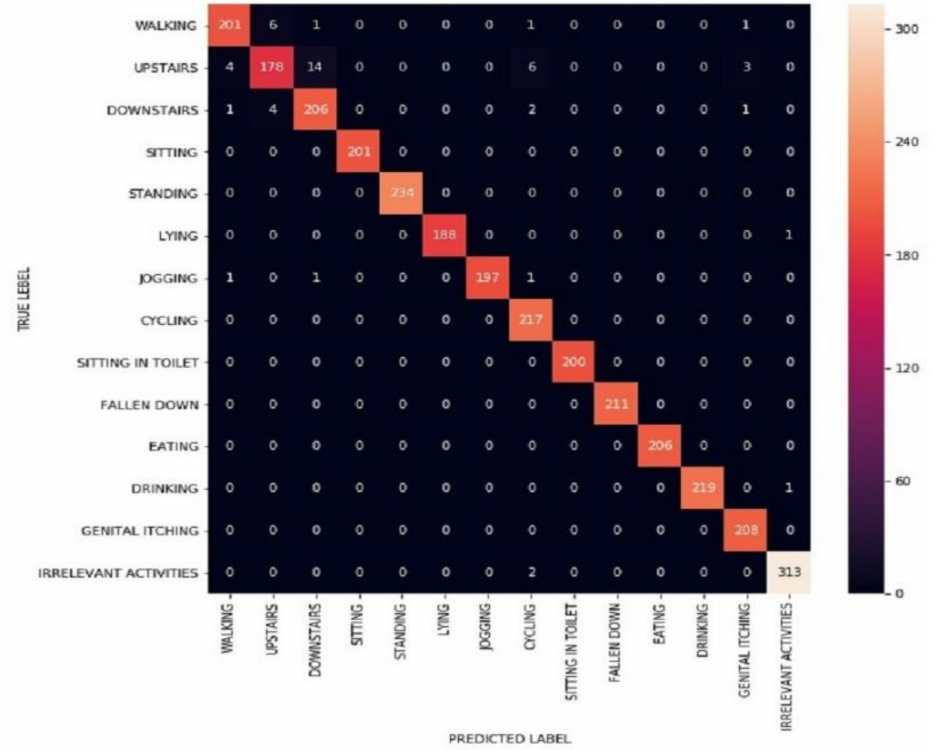
Figure 6. Confusion matrix of the LSTM